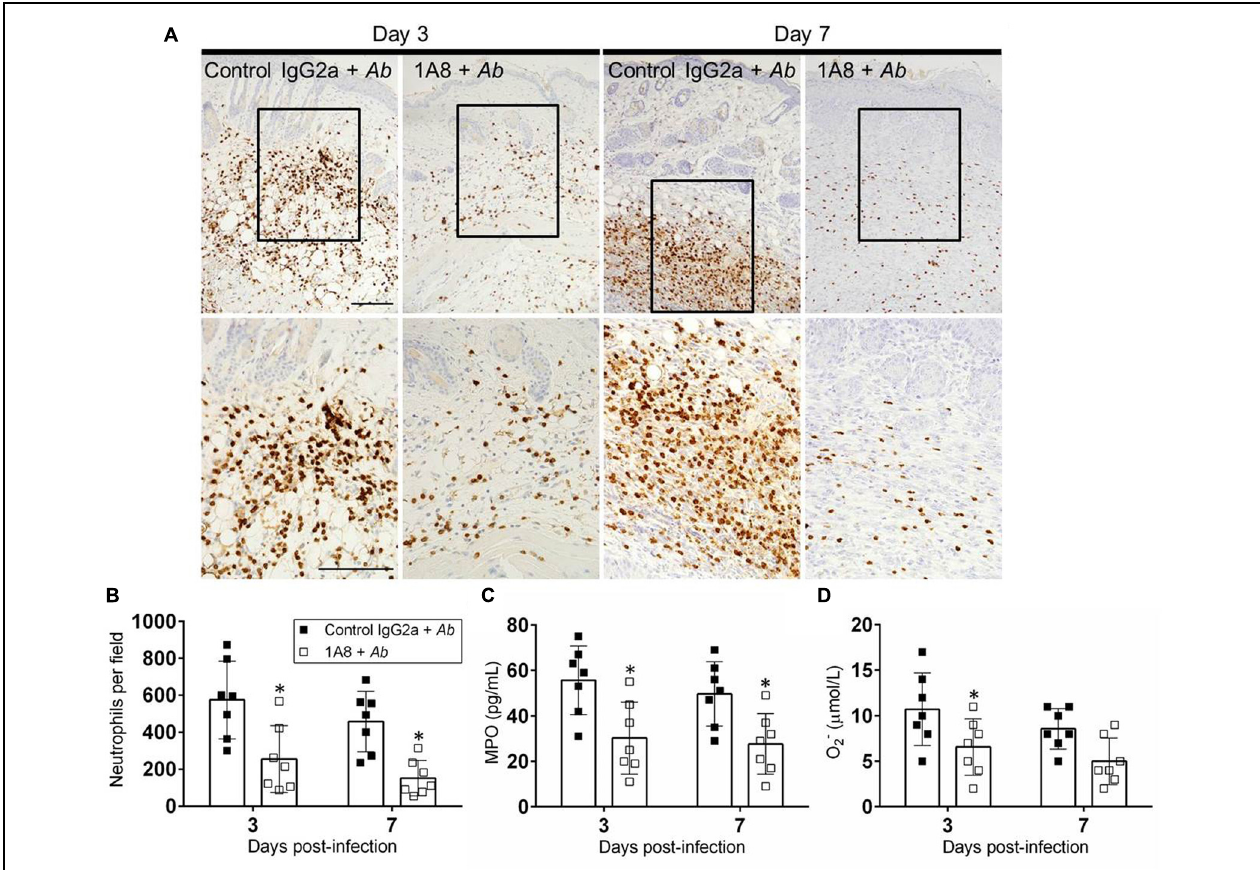
FIGURE 5 | MAb 1A8 administration decreases cutaneous neutrophil infiltration. (A) IHC of MPO released by neutrophils in wounds removed from A. baumannii -infected (control IgG2a + A. baumannii ), and mAb 1A8-treated A. baumannii -infected (1A8 + A. baumannii ) mice. MPO-specific mAb was used to stain MPO (dark) released in skin tissue indicative of neutrophil infiltration. Inset shows restricted dermal accumulation of neutrophils. Representative 20X (upper panel) and 40X (lower panel; magnified black boxes in upper panel) MPO-immunostained sections of the skin lesions are shown. Scale bars: 20 μ m. (B) Number of neutrophils per field in wounded skin tissue of control IgG2a + A. baumannii and 1A8 + A. baumannii animals. (C) MPO concentration in the supernatant of tissue homogenates excised from control IgG2a- and mAb 1A8-treated A. baumannii -infected mice. (D) Superoxide (O 2 − ) production was quantified by measurement of SOD1 activity in tissue homogenates excised from control IgG2a + A. baumannii and 1A8 + A. baumannii mice. For (B–D) , bars represent the mean values for seven clinical isolates (each symbol); error bars denote standard deviations. Asterisks denote P -value significance ( ∗ P < 0.05) calculated using student’s t -test analysis. The experiments were performed twice with similar results